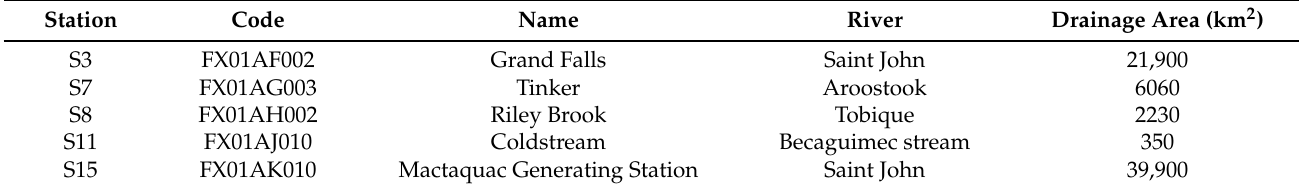
Figure 1. Three different vine structures obtained from the Saint-John basin structure. The blue circles represent the vine nodes which are the analyzed control stations listed in Table 1. The thick black arrows represent the vine edges. The black lines represent the sub-catchment delimitations. Table 1. Control stations selected to illustrate the Vine-copula